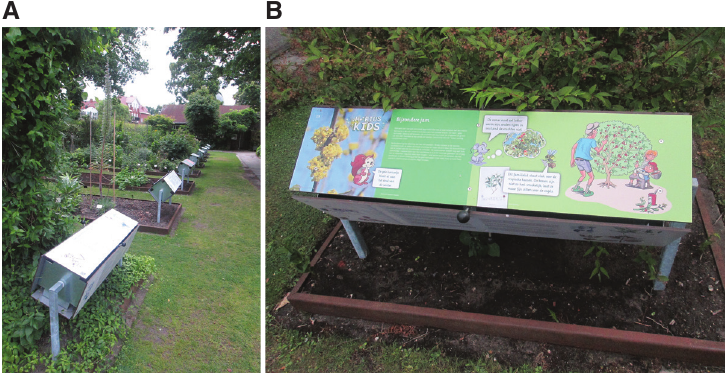
Figure 2 (A) General view of rotating information panels from the Plant- eater exhibition at Hortus botanicus Leiden; (B) A view of the text available for children on a rotating four-sided panel from the same exhibition (Source: photographs by Georgios